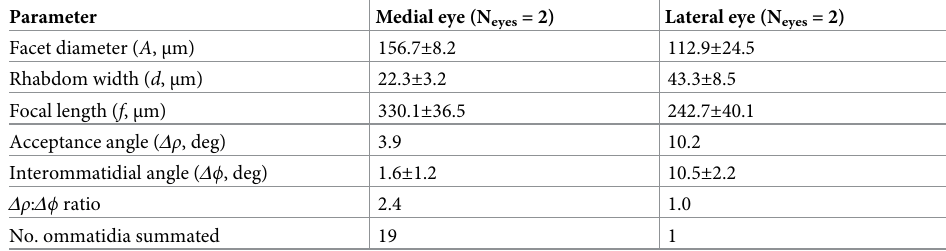
Table 2. Average medial and lateral right eye parameters for two Phronima specimens based on measurements from micro-CT reconstructions. Measurements are given as mean ± standard deviation. For each eye type, the aver- age and standard deviation for facet diameter and rhabdom width were calculated from all ommatidia within the right eye of each specimen (N = 424 and 428 for the medial eyes and N = 261 and 265 for the lateral eyes), using these values, we then calculated the average between the two specimens (for both means and standard deviations). The average and standard deviation for focal length were calculated with a similar method but the measurements were taken from a sub- set of ommatidia within the right eye of each specimen (N = 50 for each eye type). Acceptance angles in degrees approximated using d / f using the average values of d and f (converted from radians; [36,37]). “No. ommatidia sum- mated” represents the number of spatially summated neighbouring